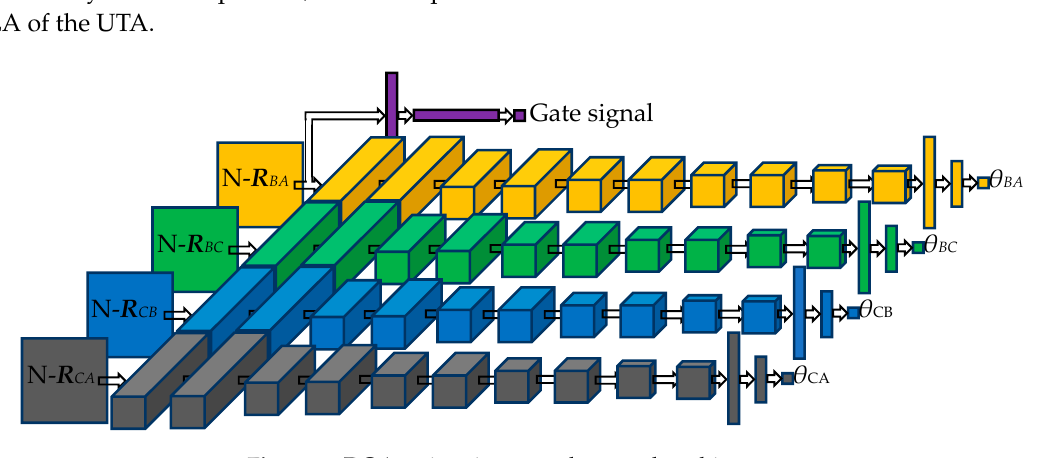
Figure 7. DOA estimation neural network architecture.